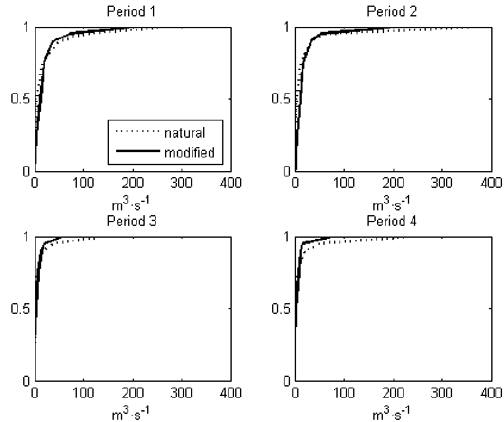
Figure 2. CDF curves of daily natural flow (dot line) and daily modified flow (thick line) for the four periods corresponding to in- creasing storage levels, in the Guadalete River.